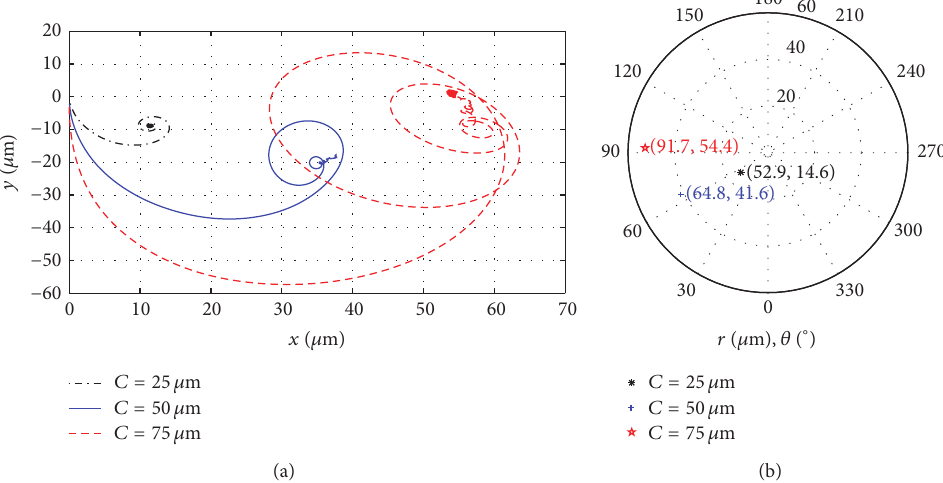
Figure 17: (a) Rotor trajectory and (b) polar coordinates of the HGGJB under different bearing radial clearance at the rotating speed of 10000